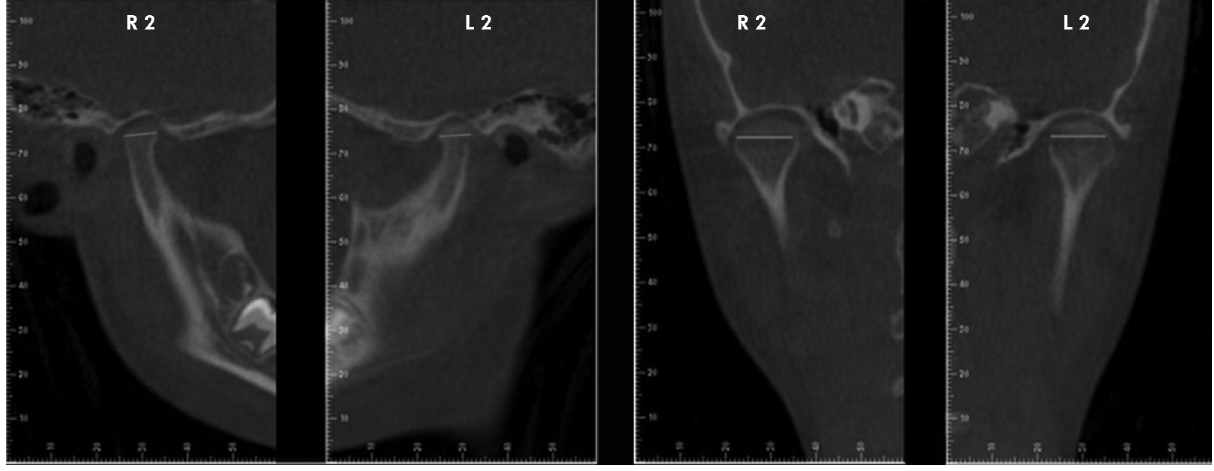
Figure 3. Measures in Sagittal and Coronal Planes – Software Dolphin 3D ® (Dolphin Imaging/Patterson Dental, Chatsworth, USA).